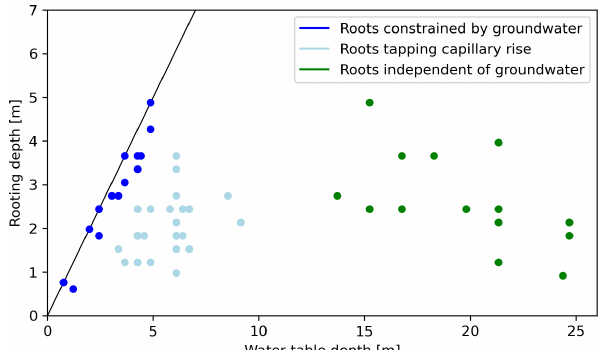
Figure 1. Illustration of the effect of water table depth on plant wa- ter uptake strategies, showing the rooting depth of 47 trees in east- ern Nebraska plotted against water table depth measured at their specific sites. Soil and climate properties are relatively constant in the region. The roots can be divided into three distinct categories: (1) root growth is restricted by the groundwater, (2) roots are tap- ping the capillary rise, and (3) roots are independent of the ground- water. Data from Sprackling and Read (1979) and interpretation adapted from Fan et al.